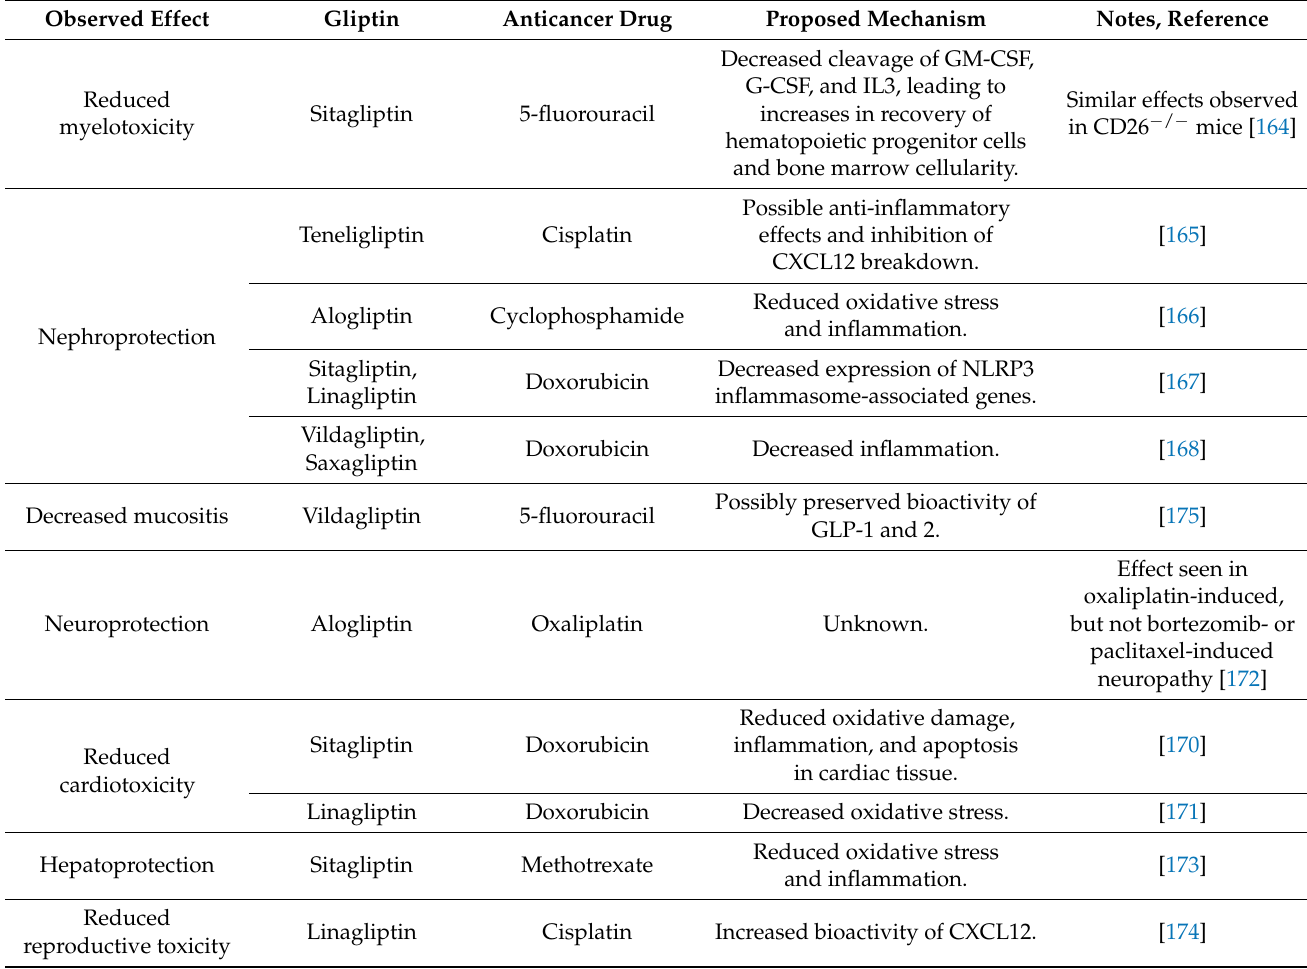
Table 6. Summary of studies suggesting amelioration of side-effects of chemotherapy by